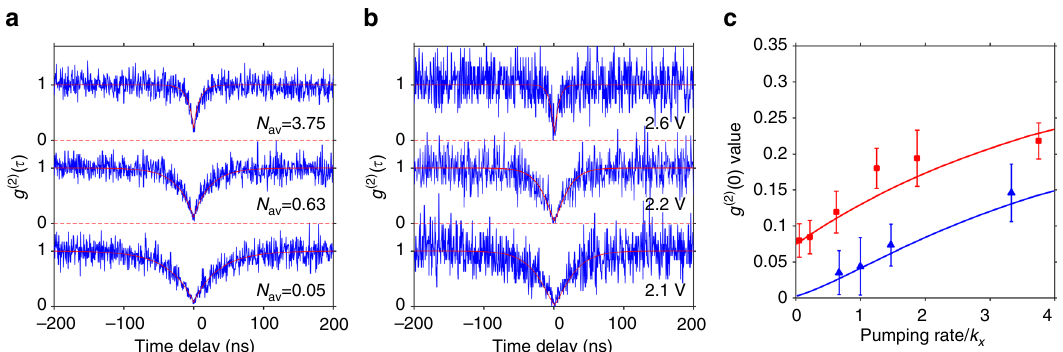
Fig. 4 Single-dot g (2) ( τ ) at different excitation conditions. a , b Antibunching curves of single-dot photoluminescence and electroluminescence at different excitation levels, respectively. N av in a , which is proportional to the excitation power, stands for the number of photons absorbed per lifetime cycle of excitons. c The dependence of simulated g (2) (0) on the relative pumping rates ( k X = 25 μ s − 1 is the decay rate of an exciton) for photoluminescence (red curve) and electroluminescence at the situation of balanced charge injection (blue curve). Red squares and blue triangles are experimental data for photoluminescence and electroluminescence from respective single-quantum dots, respectively. Standard deviations were calculated based on the values of four data points around zero time delay and plotted as